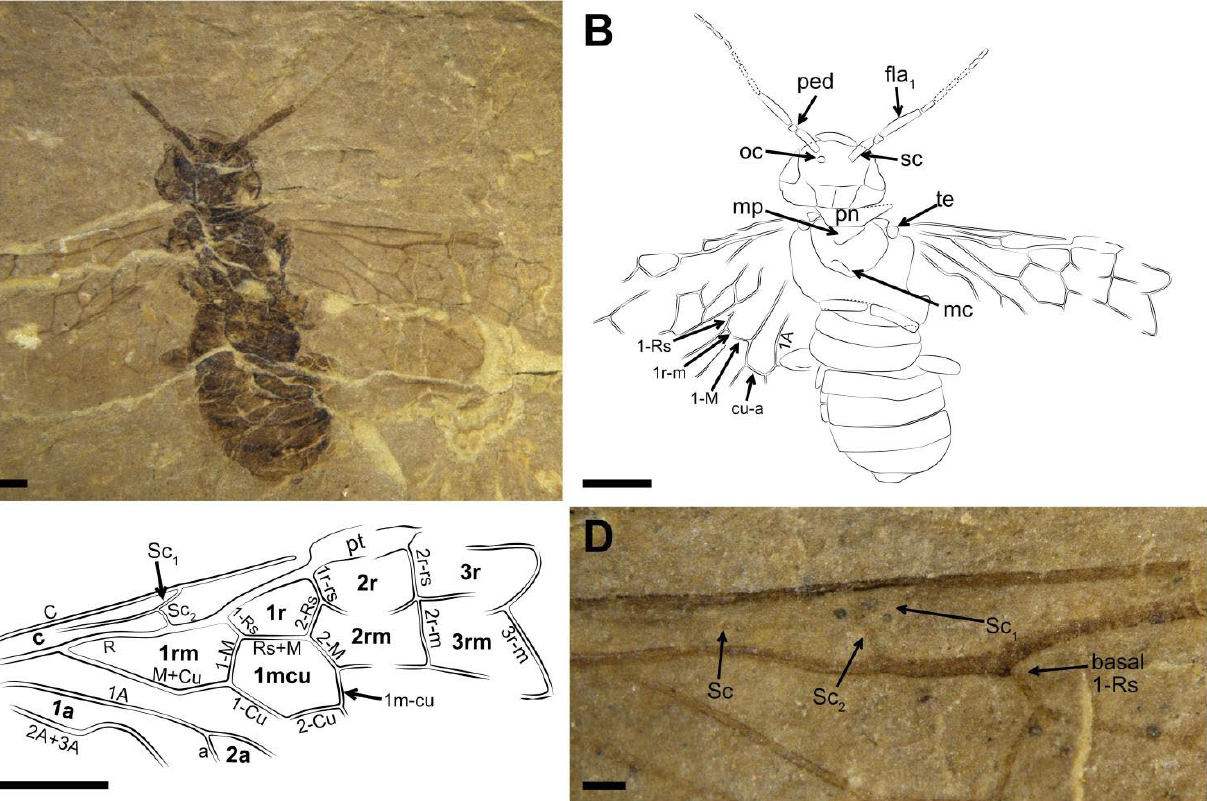
Figure 4. Scabolyda tenuis sp. nov., Holotype (CNU-HYM-NN2022104) sex unknown. ( A ) Dorsal view of body as preserved. ( B ) Line drawing of body. ( C ) Line drawing of forewing (partly). ( D ) Photo of Sc in forewing. Symbols: oc = ocellus; pn = pronotum; mp = mesoprescutum; mc = mesoscu- tellum; te = tegula. Scale bars: 2 mm in A–C; 0.25 mm in ( D